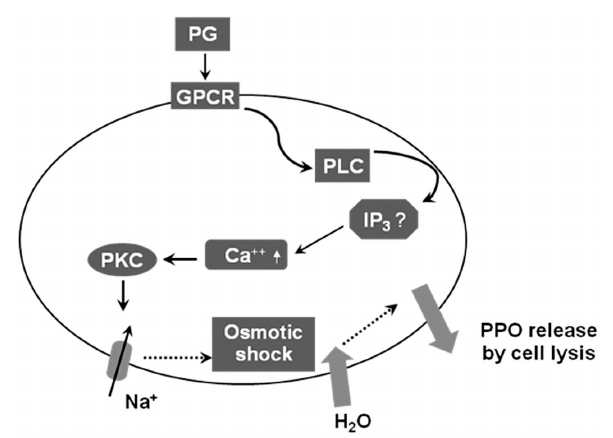
FIGURE 5 |A working hypothesis of the intracellular signal pathway of enocytoid lysis in response to PGs in Spodoptera exigua . Following bacterial challenge, PGs are produced and bind to membrane receptors (“GPCR”) on enocytoids, which activates phospholipase C (PLC) and releases inositol trisphosphate (IP 3 ).The secondary messenger then up-regulates intracellular calcium level and activates protein kinase C (PKC). The activated PKC may induce opening of Na + channels and increase osmotic pressure, which allows influx of water, responsible releasing prophenoloxidase (PPO) by lyzing the